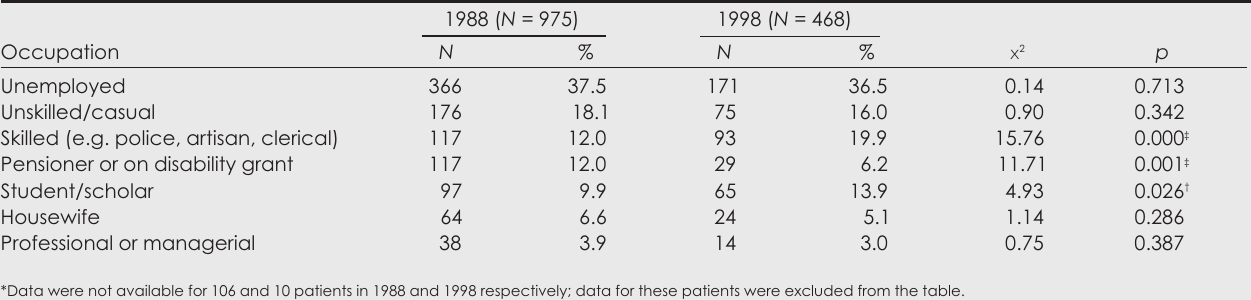
Table I. Occupations of patients attending the psychiatric emergency services unit, Groote Schuur Hospital, 1988 and 1998*